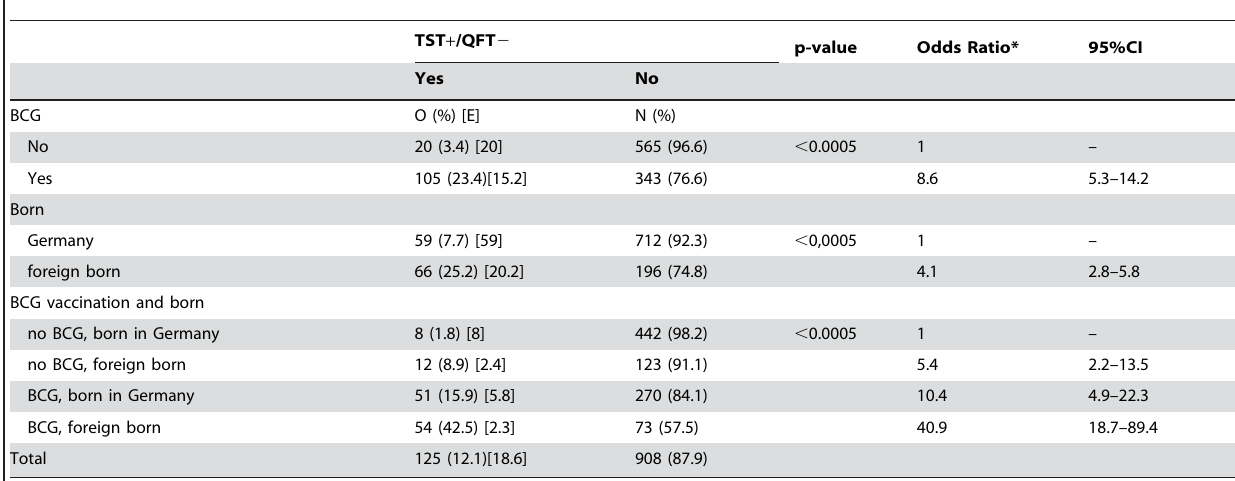
Table 4. BCG vaccination or foreign born as putative cause for TST + /QFT 2 Discordance.